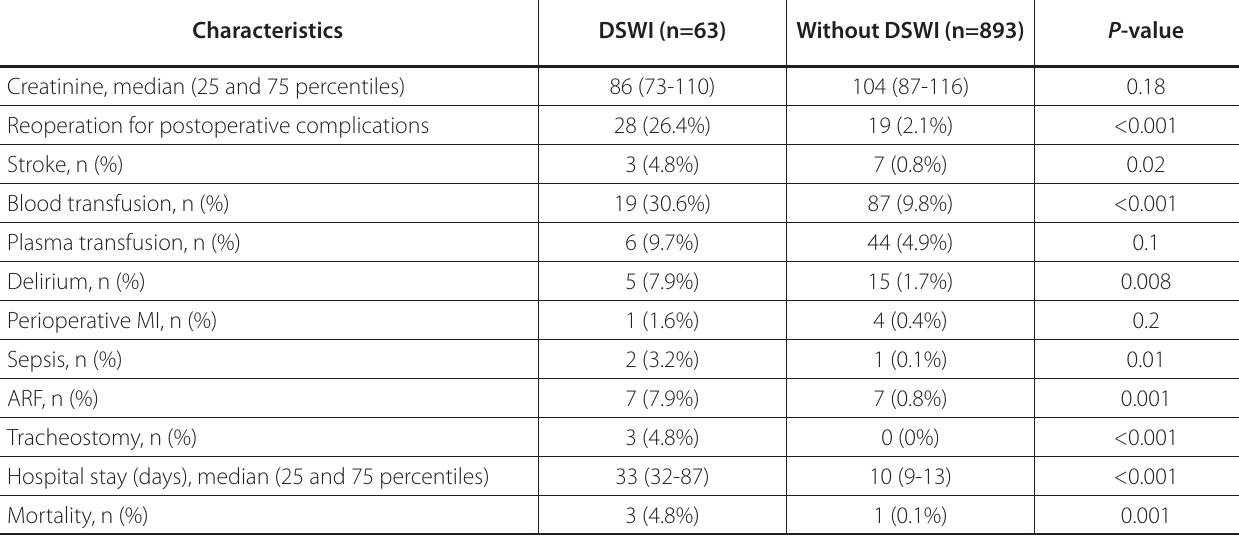
Table 3 . Postoperative risk factors for sternal